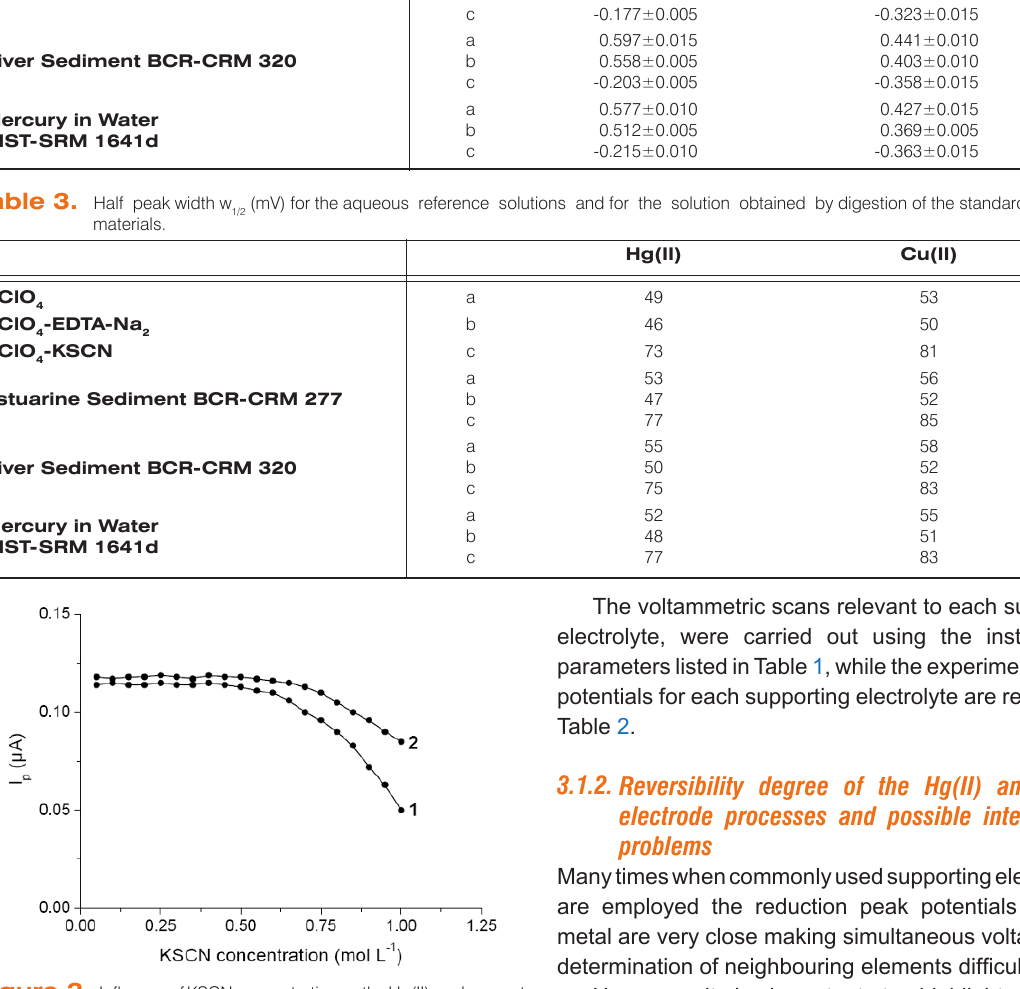
concentrations. 4 concentrations 4